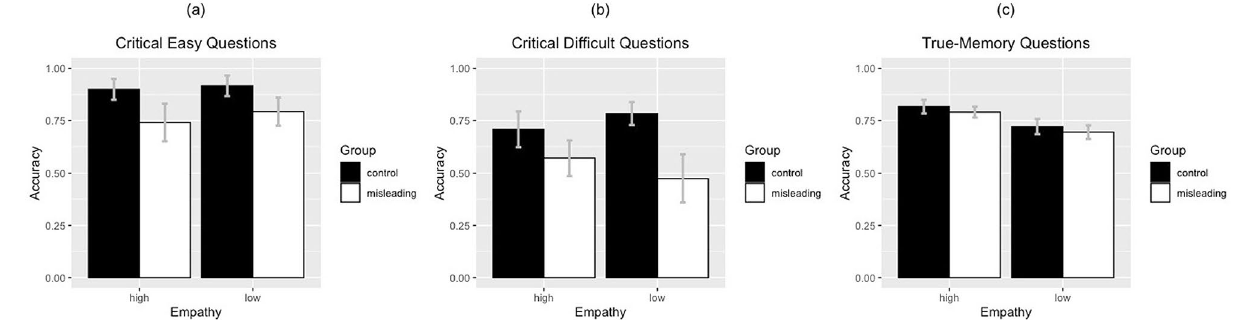
Figure 1. The accuracy of memory performance for (a) critical easy, (b) critical difficult, and (c) true-memory questions. The error bars indicate the 95% confidence